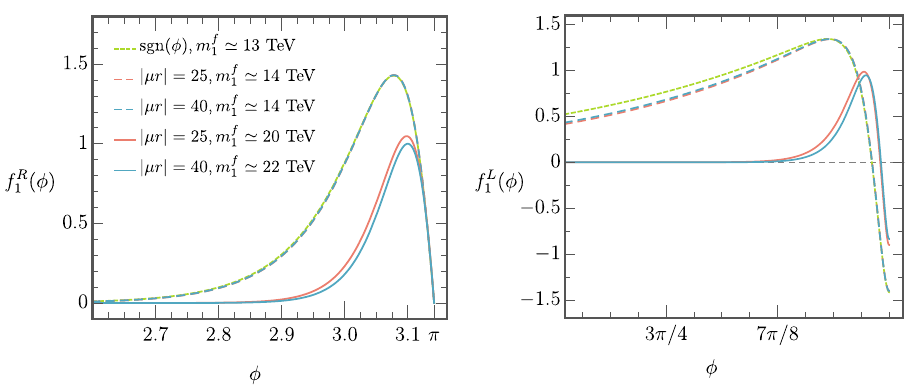
Figure 10 . Examples of pro(cid:12)les of the (cid:12)rst KK resonances of a fermion with a left-handed zero mode, obtained in the original RS model (green), i.e. using a sgn( (cid:30) ) function in front of the bulk masses, and in the model where the bulk masses are generated dynamically through the VEV of a scalar (cid:12)eld, considering strong and no backreaction (solid and dashed lines, respectively). We use the background solutions shown in (cid:12)gure 6. The left (right) panels show the pro(cid:12)les for the right-handed (left-handed)